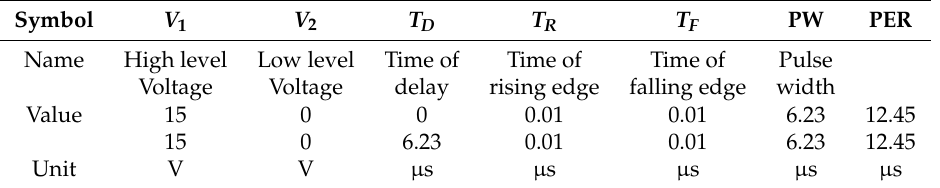
Table 2. Parameters for driving the MOSFET gates.